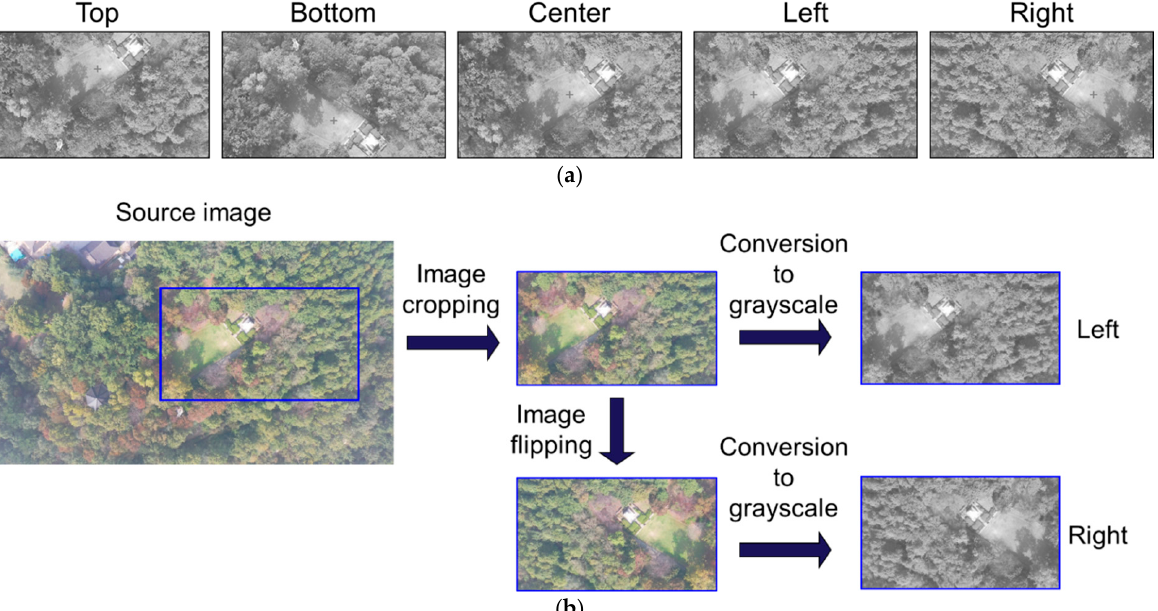
Figure 4. ( a ) Frame images corresponding to the five gaze positions and ( b ) a framework of the image generation process.